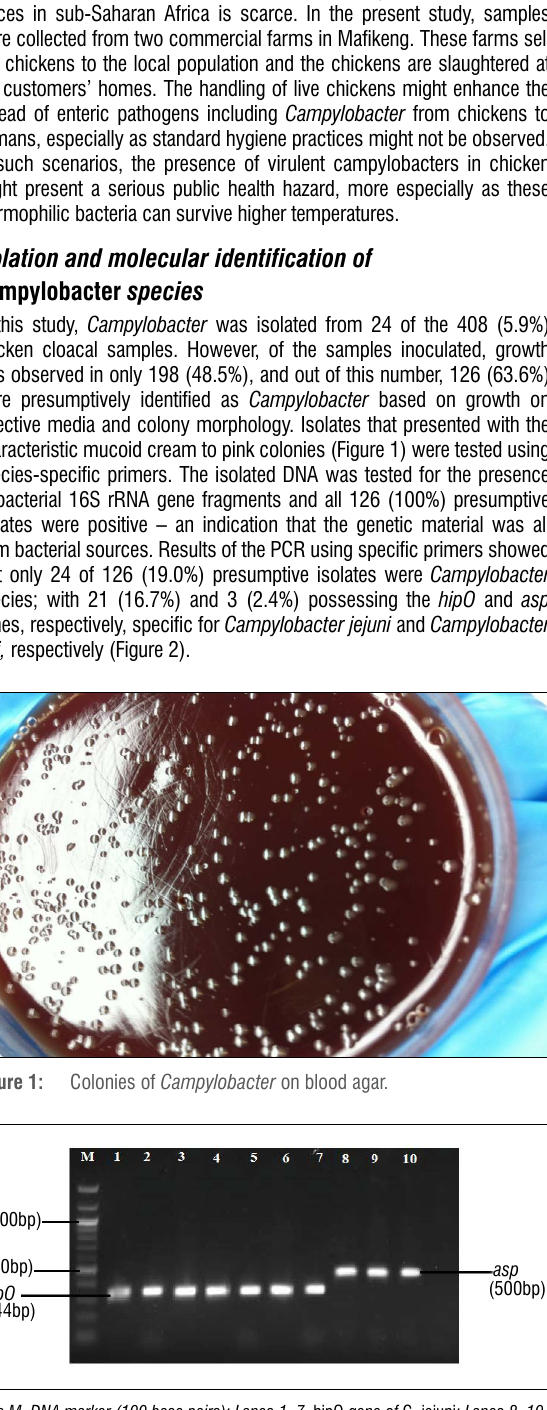
Figure 2: Agarose gel of the hipO and asp genes. DNA Sequencing